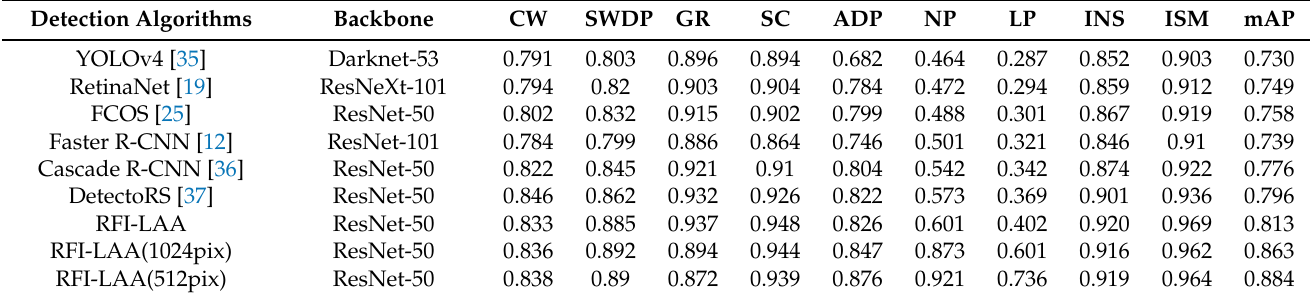
Table 3. Comparison of results of all kinds of detection